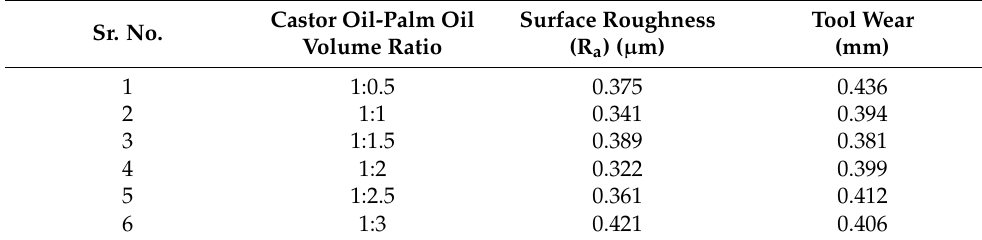
Table 7. Roughness and Tool Wear at Different Oil Ratios. Sr.